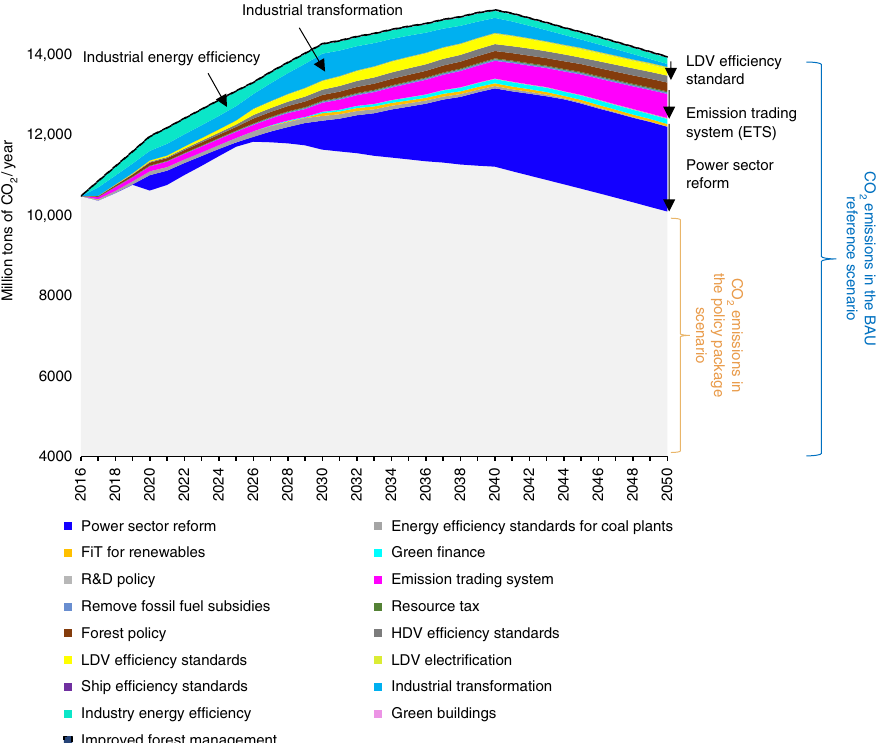
Fig. 7 Annual CO 2 reductions by policy in the policy package scenario relative to the BAU reference case scenario. R&D refers to research and development. LDV refers to light-duty vehicle and HDV refers to heavy-duty vehicle. The various colorful segments show how much each policy can reduce CO 2 emission. The results show that no single policy results in the achievement of China ’ s CO 2 emissions peak by 2026. The top fi ve most effective policies before 2030 are power sector reform, industrial transformation, industrial ef fi ciency, ETS, and LDV ef fi ciency